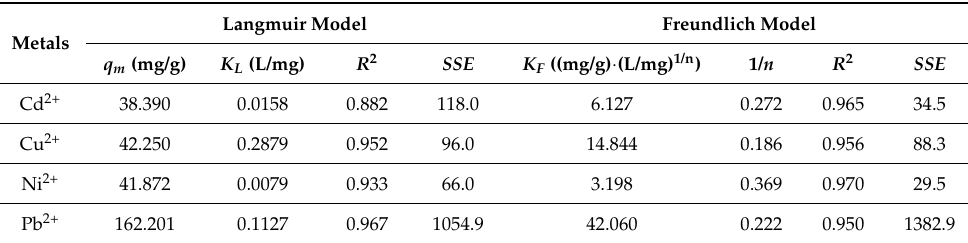
Table 4. Langmuir and Freundlich model parameter of Cd 2+ , Cu 2+ , Ni 2+ , and Pb 2+ sorption by 1 M NaOH-treated H. fusiformis .